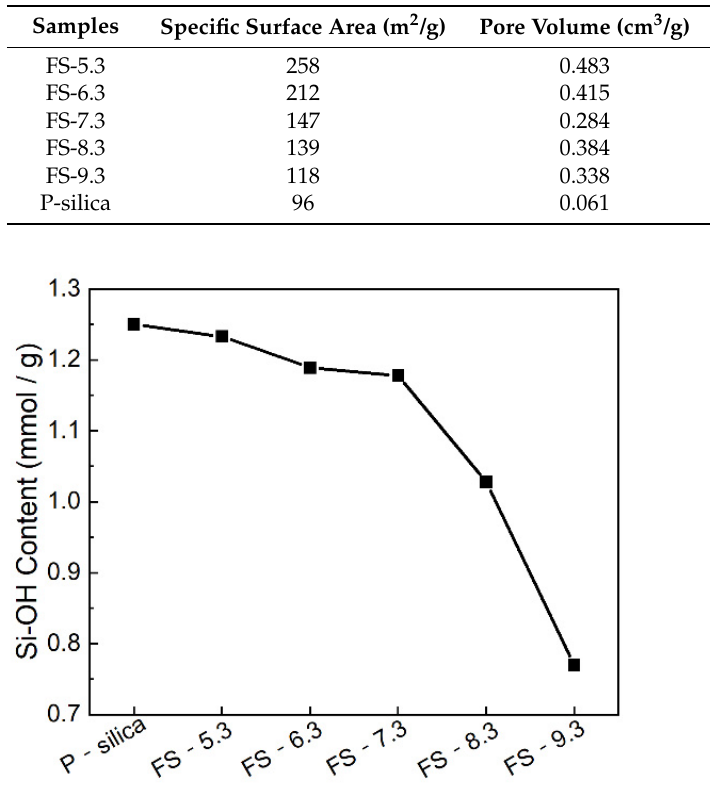
Figure 4. Si-OH content of P-silica and FS-SiO 2 .